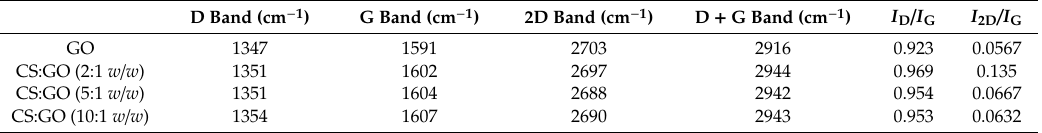
Table 1. Summary results of Raman analysis for GO and CS:GO nanocomposites.